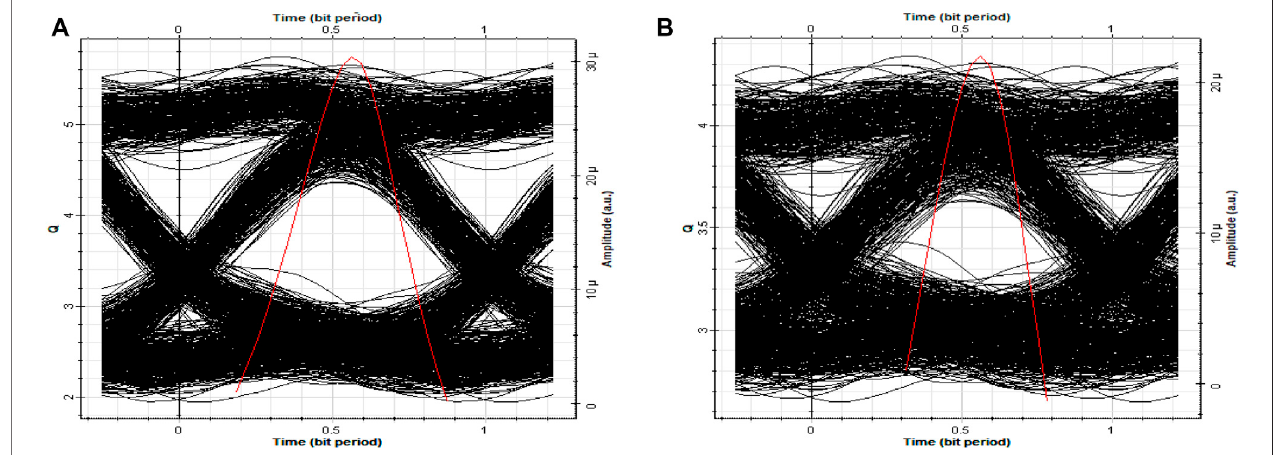
FIGURE 8 | Eye diagram using the proposed NRZ-based MDM-RoFSO link at 950 m transmission distance under light dust conditions for the (A) HG00 channel and (B) HG01 channel.